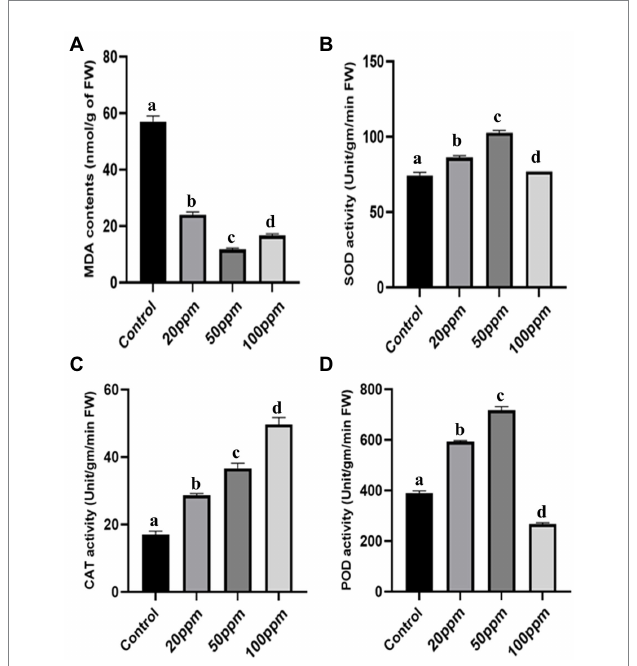
FIGURE 6 The effect of GRH foliar spray (20, 50, and 100 ppm) on malondialdehyde (MDA) contents (A) , peroxidase (POD) activity (B) , catalase (CAT) activity (C) , superoxide dismutase (SOD) activity (D) of O. sativa ssp. indica MTU 7093 swarna in comparison to control. Values on the graphs are the means ± Standard error (SE) of three replicates. Tukey’s multiple comparison test was performed. The letters a, b, c, and d indicate significant differences compared to the control plant (At, p <